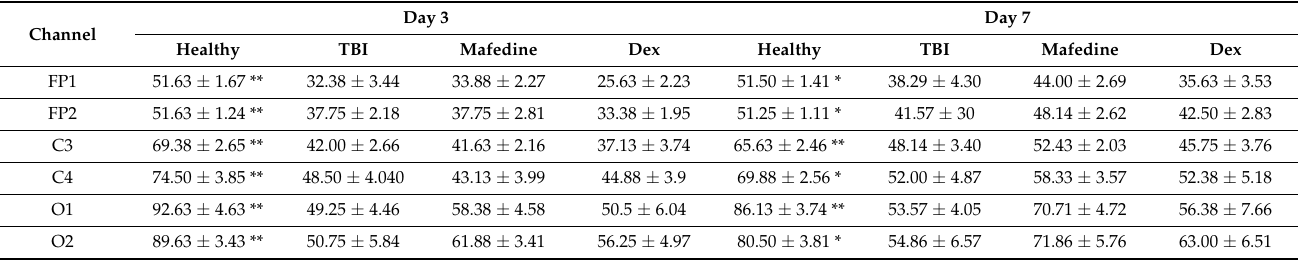
Table 2. Mean corticographic signal amplitudes ( µ V) in channels FP1, FP2, C3, C4, O1, and O2 at post-TBI days 3 and 7. Day 3 Day 7 Channel